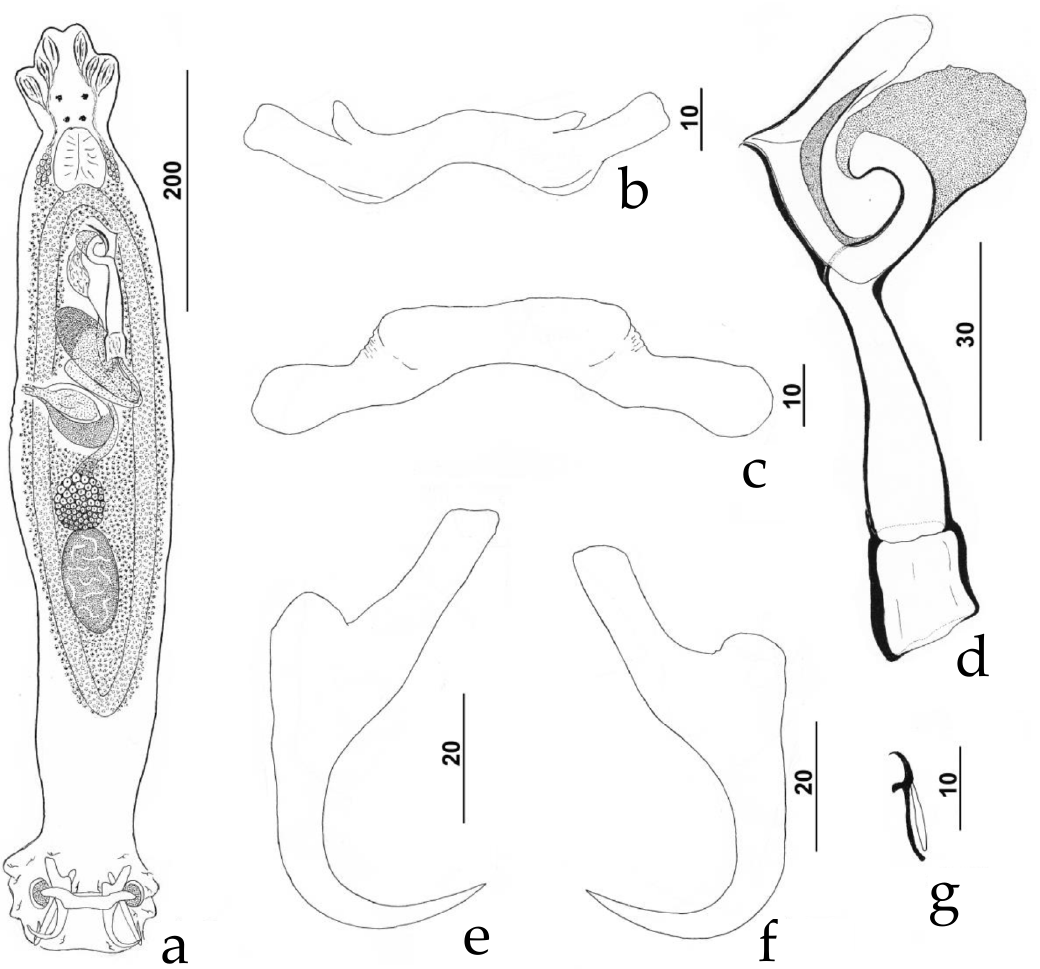
Figure 2. Platycephalotrema koppa n. sp. ( a ). Whole mount (composite, ventral view); ( b ). dorsal bar; ( c ). ventral bar; ( d ). male copulatory organ (dorsal view); ( e ). ventral anchor; ( f ). dorsal anchor; ( g ).